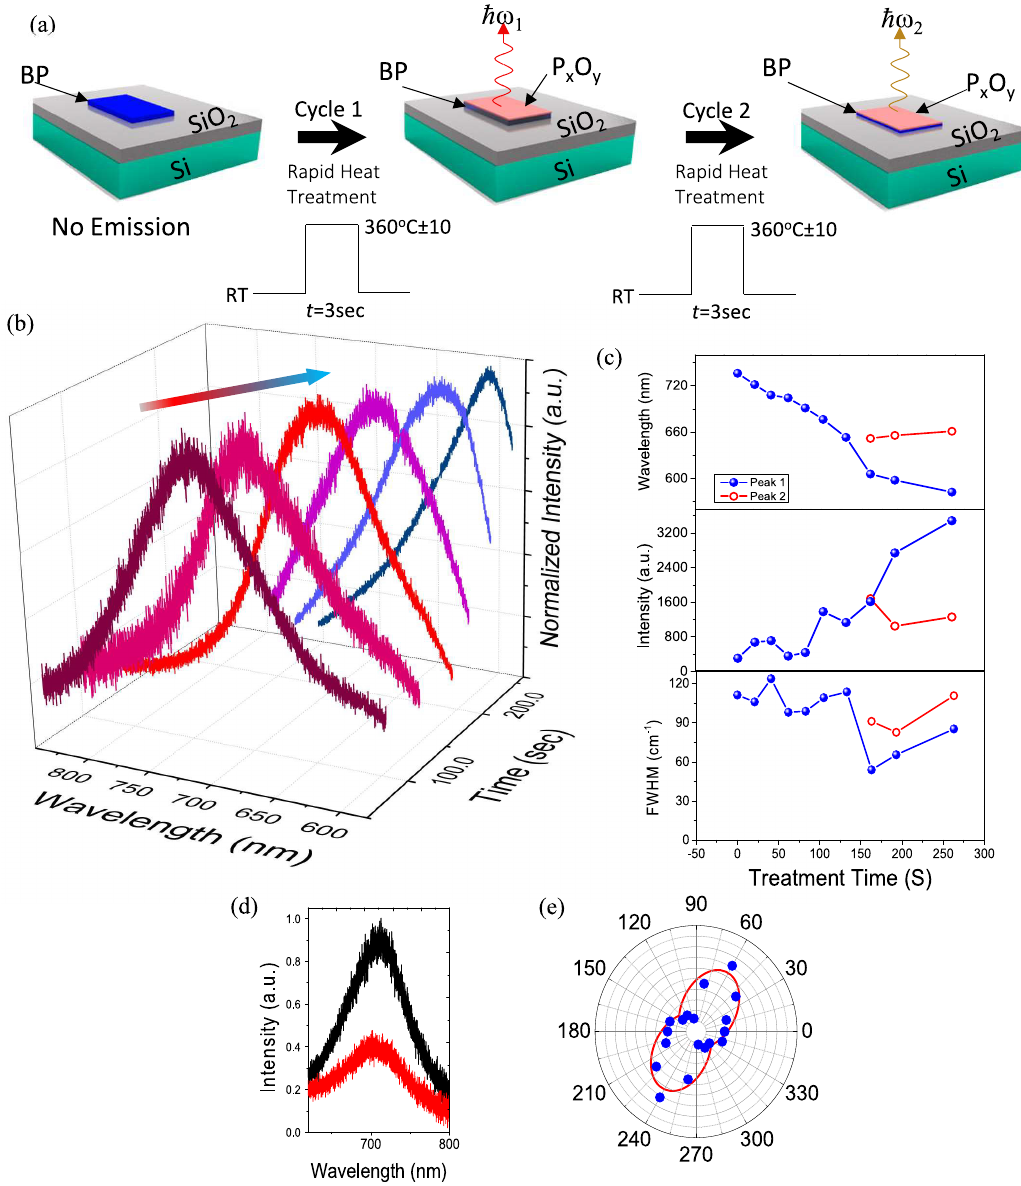
Figure 1: (a) Schematic diagram showing the pulsed thermal annealing process of exfoliated black phosphorus after exfoliation with no light emission, after cycle one of treatment and emitting at wavelength ( ω 1 ), and after cycle two of treatment and emitting at wavelength ( ω 2 ). (b) Photoluminescence (PL) intensity versus wavelength ( λ ) at different treatment times for a 120 nm thick exfoliated black phosphorus nanosheet. The treatment time shown for each cycle is cumulative. Arrow indicates the direction of increasing treatment cycles. (c) PL wavelength, intensity, and linewidth of unnormalized data sets. (d) PL spectra of another pulsed thermally annealed black phosphorus nanosheet at a 90 ° angle difference. (e) PL intensity versus angle showing anisotropic